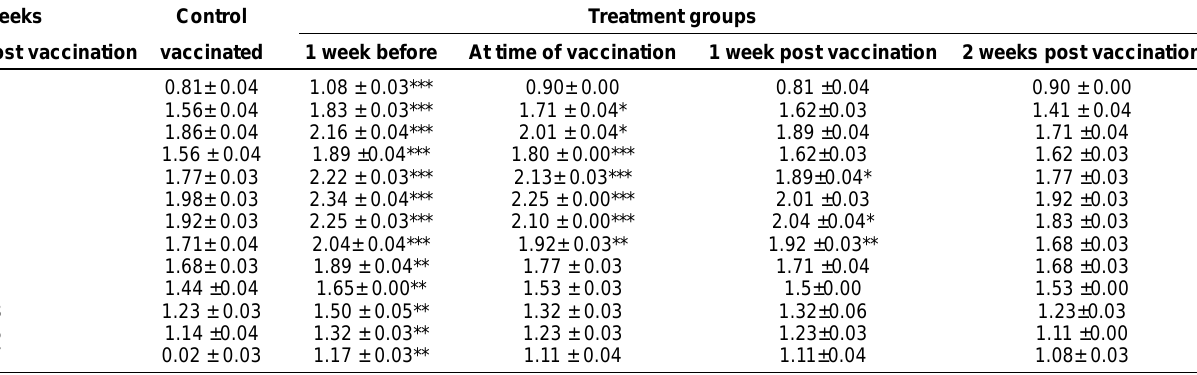
Table-5. Effect of intramuscular injection of Imidocarb dipropionate (3mg/Kg b.wt.) on the serum neutralization antibody titre expressed by Log10 in the normal calves vaccinated with FMD vaccine (±S.D. n=5). Weeks